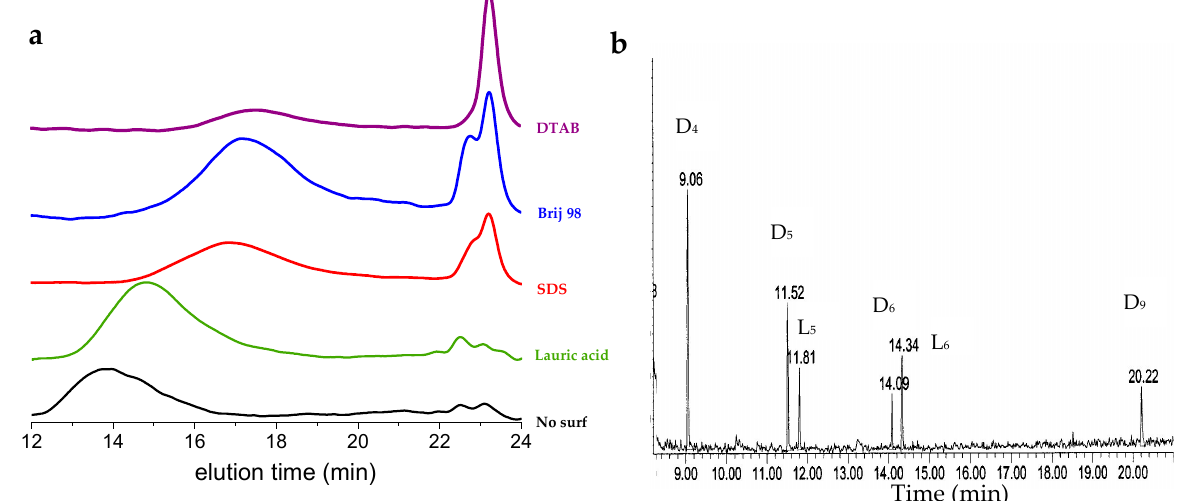
Figure 4. ( a ) SEC traces of different trials done in presence of surfactant, compared to pristine one. For polymerization conditions, see Table 2; ( b ) GC-MS analyses of D 3 /BCF/Brij system after 12 h of reaction.